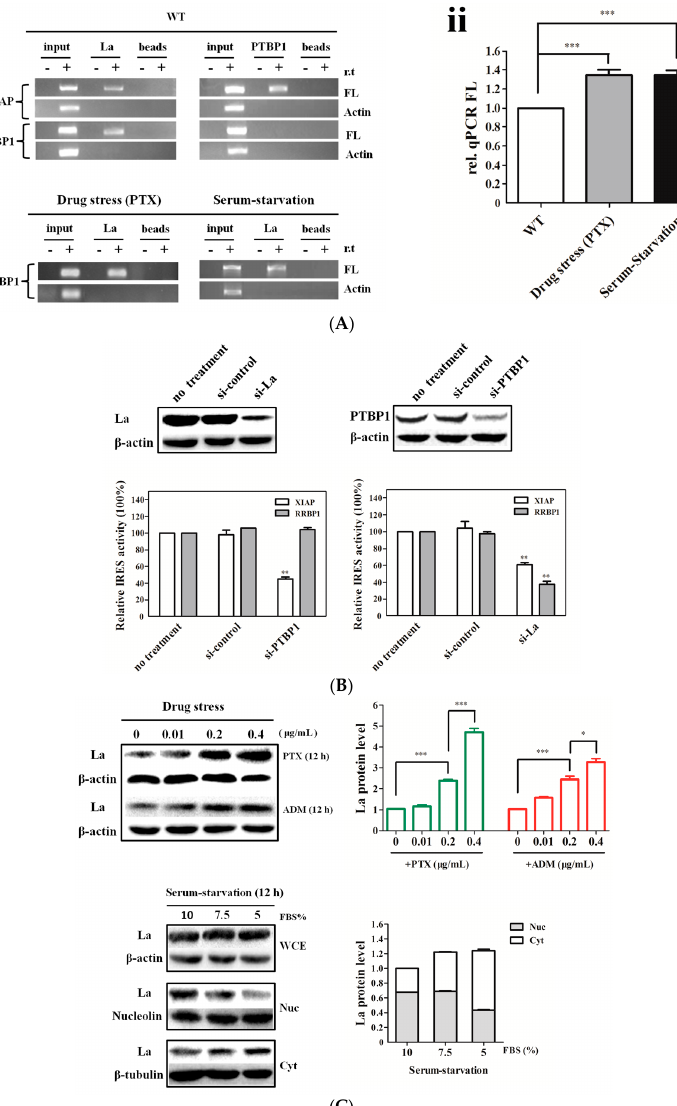
Figure 3. The RRBP1 IRES upregulates translation during stress conditions. The construct pR-RRBP1-F shown in Figure 2A was transfected into Bel7402 cells treated with and without increasing concentration (0.01, 0.2 and 0.4 μ g/mL) of PTX or ADM, respectively. Meanwhile, the vector was also transfected into Bel7402 cells growing under normal medium and serum-starvation conditions. FL and RL activity were determined and the IRES activity was shown. The expression data are presented as the mean ± SEM of triplicate samples (*: p < 0.05; **: p < 0.005).